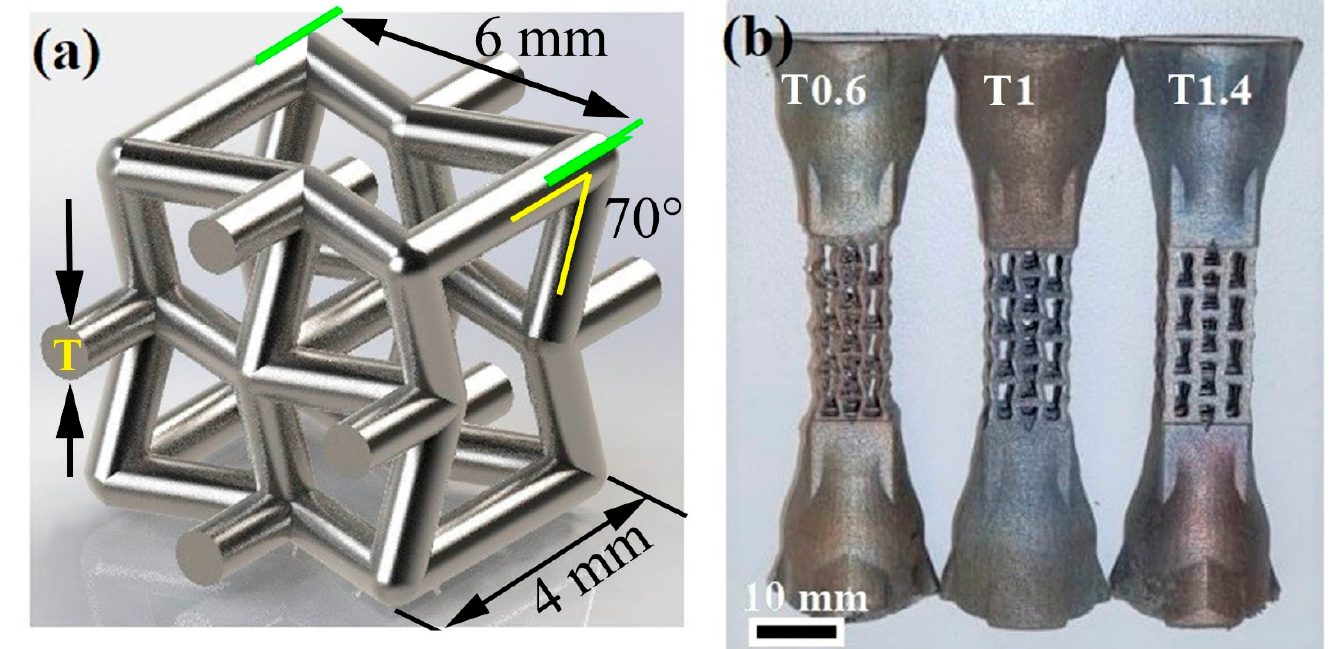
Figure 1. ( a ) Shape and dimensions of one unit cell of the printed 316L lattice structure; ( b ) macrograph of H charging sample geometry showing the lattice structure with different thicknesses. T refers to the strut thickness.